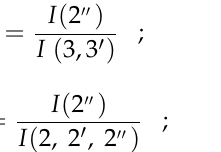
fonated polymers.